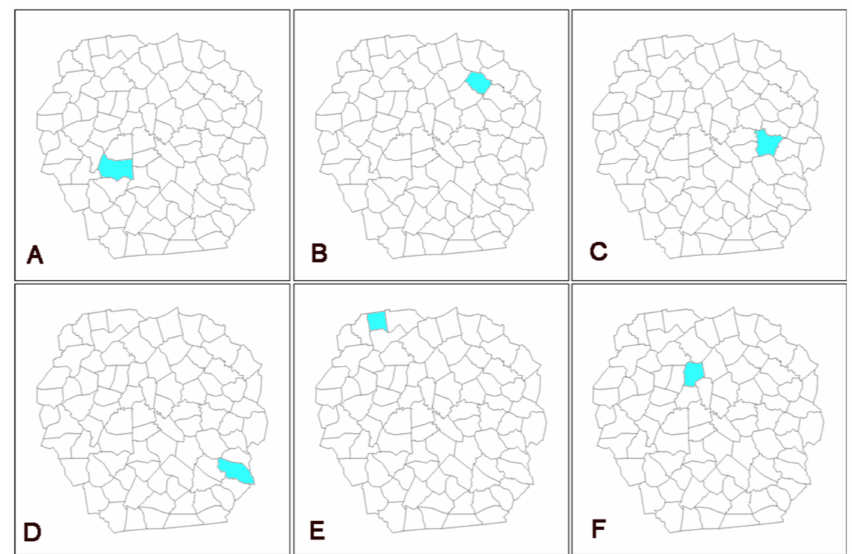
Figure 2. Local outlier response items for stimulus 1. Participants could choose between six outlier candidates ( A – F ). Option F shows the local outlier from Figure 1.